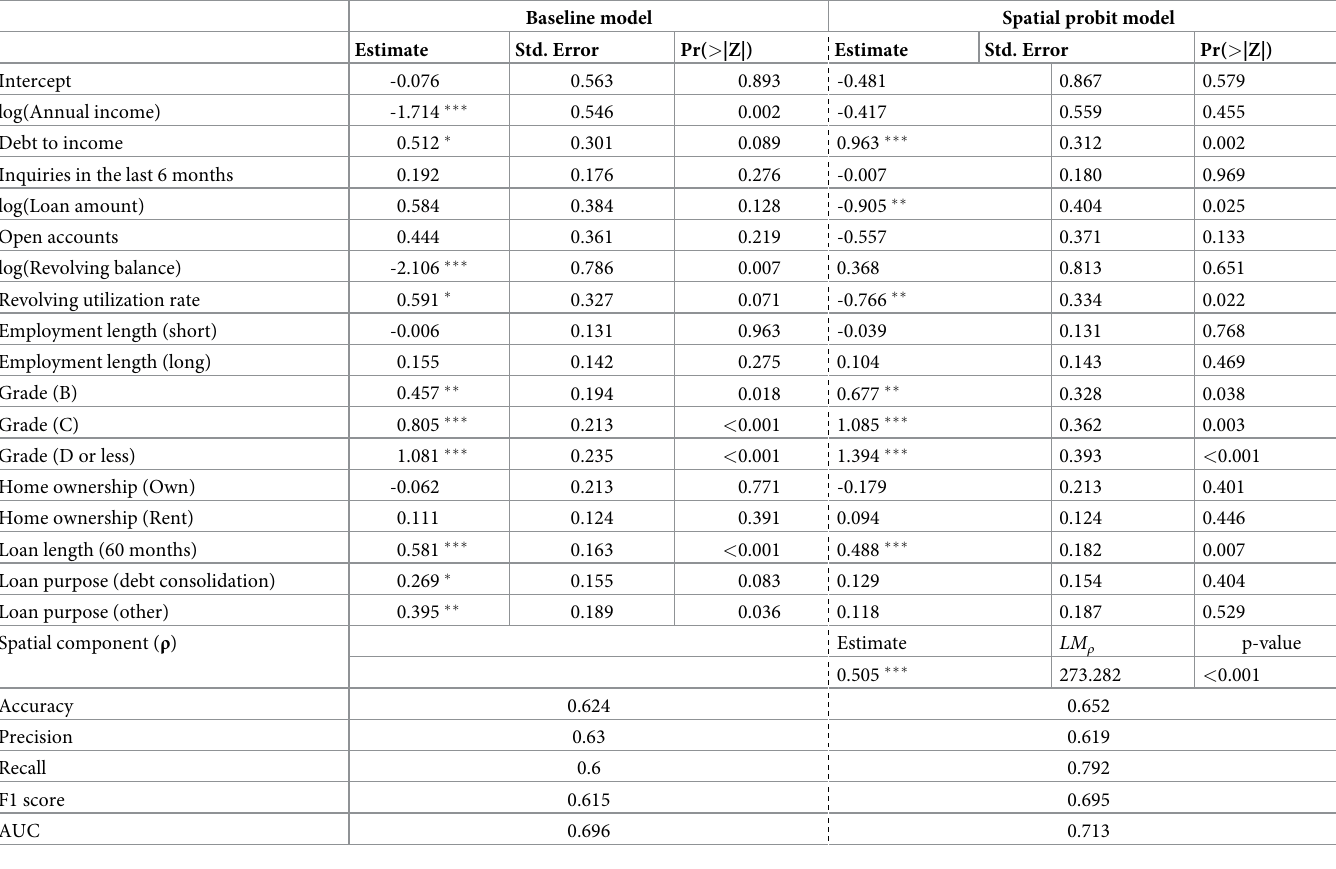
Table 4. Result of the estimation of the baseline and SAR